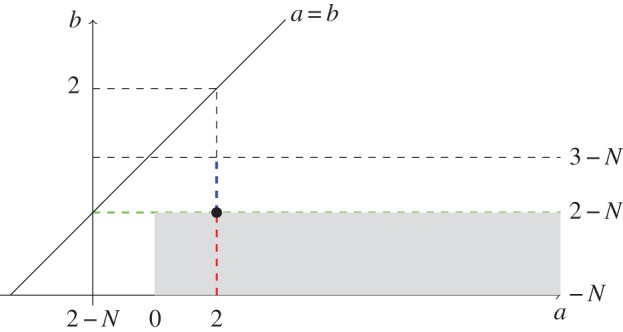
Parameters for minimizers of the interaction energy with potential of the form (4.8) given by densities. See the text for a full explanation.